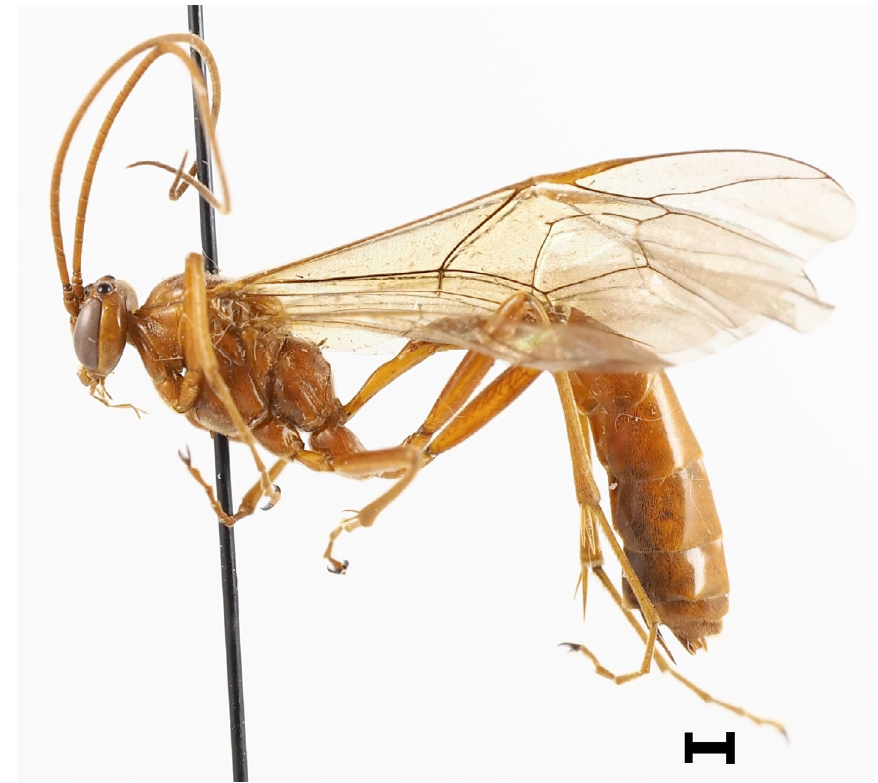
Fig. 39. Ophion paukkuneni Johansson sp. nov., holotype, ♀ (NHRS-HEVA000008701). Scale bar = 1